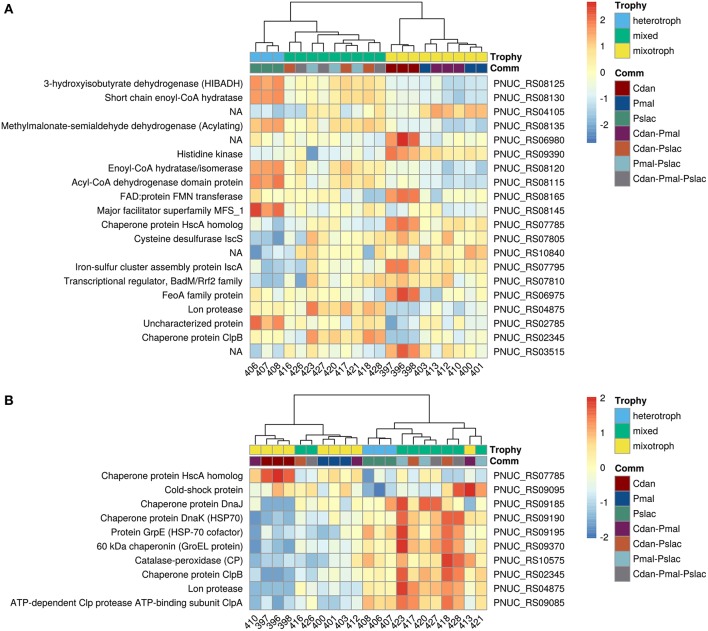
Heatmap of gene expression for Pn. asymbioticus in all samples. (A) Depicts the 20 most differentially expressed genes of 150 between the conditions in single-species samples ordered by Benjamini-Hochberg adjusted p-value. (B) depicts significant differentially expressed genes which are annotated to stress responses. The heatmaps show the z-transformed normalized read counts on log2 scale clustered using hierarchical clustering with the Ward-D2 method and euclidean distances (correlation distances yield the same clustering). The dendrograms are depicted above the heatmaps. As annotation of the samples the protistan community and the trophic mode of the community members is indicated below the dendrograms. In (A) we primarily observe a clustering of samples due to their gene expression according to single- and multi-species community and further a clustering by trophy. In (B) we observe a similar clustering by trophy and community, but with some outliers in the replicates (samples 416, 426, and 413).